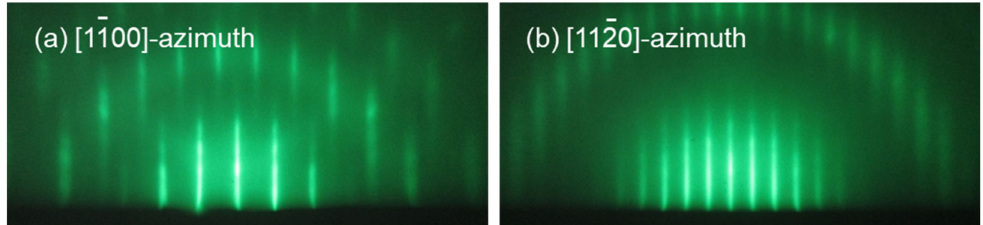
Figure 1. Reflection high-energy electron diffraction RHEED images of Cr 2 O 3 layer with (a) [1100] and (b) [1120] azimuth.